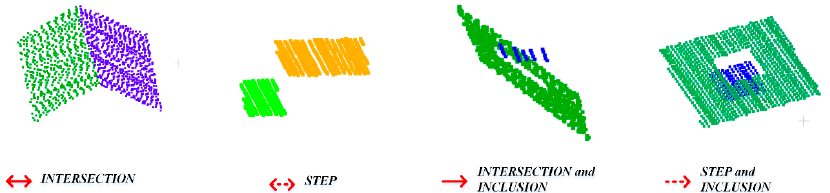
Figure 3. Four types of the relationship between two adjacent segments, which are dotted in different colors.